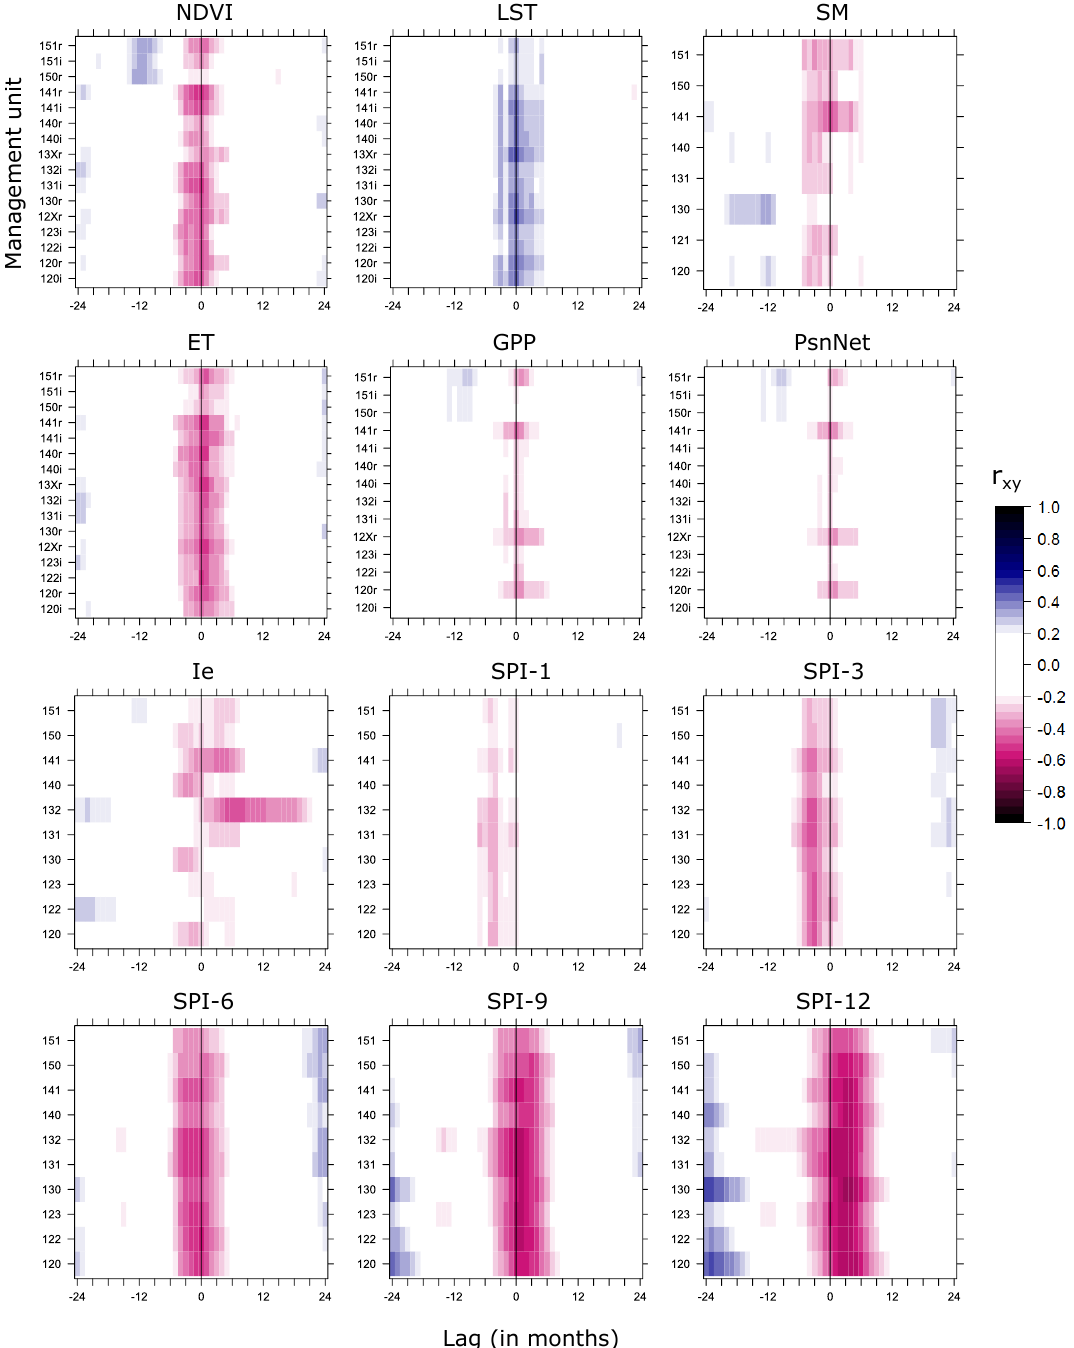
Figure 3. Cross correlation of drought indicators and drought events at multiple time lags. The numbers in the y axis represent the manage- ment areas depicted in Fig. 1. For NDVI and LST, irrigated (i) and rain-fed (r) crops within the areas are distinguished. The x axis represents the shift in months between the two data sets. The indicator built from in situ data ( I e ) is also included.